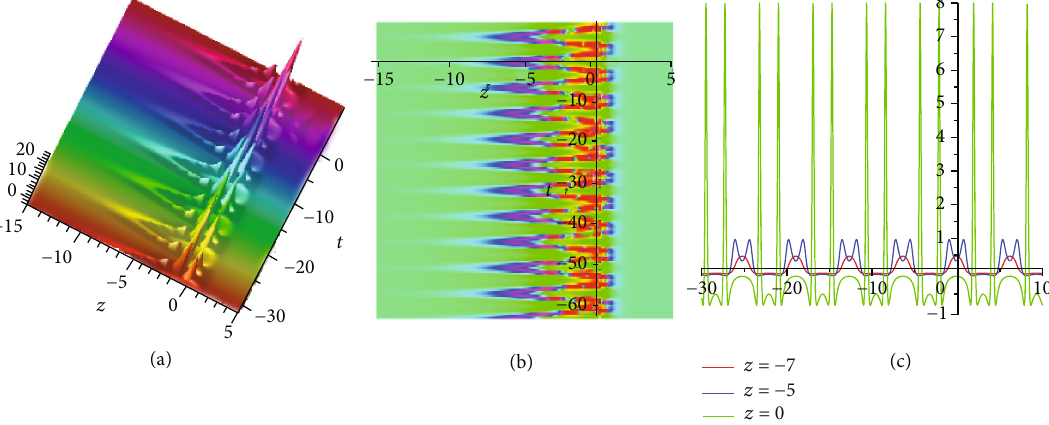
Figure 1: Plots of interaction lump with two solitons (25).